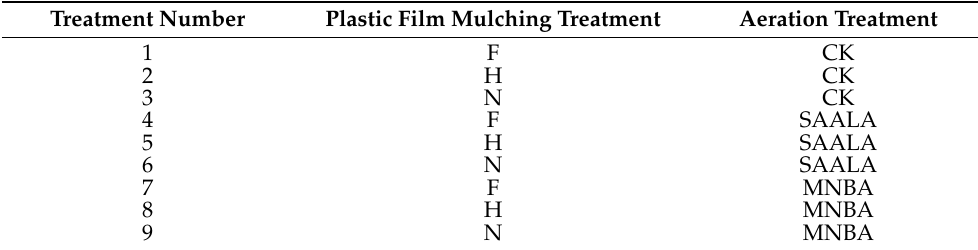
Table 1. Experimental design for the 9 treatment